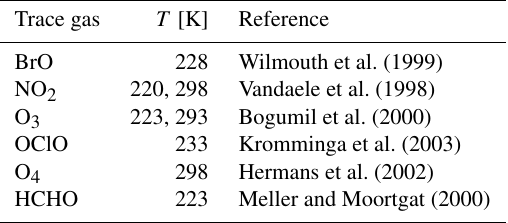
Table 2. Absorption cross sections used for the retrieval of BrO and O 4